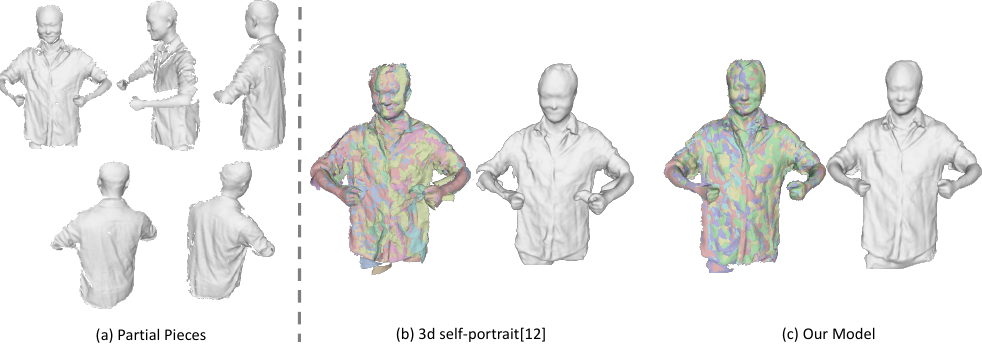
Figure 10. Comparison with 3D self-portrait. ( a ) some sampled partial pieces; ( b ) the results from 3D self-portrait [12]; ( c ) the results we get with our approach. We have colored the deformed pieces with different colors to better demonstrate the alignment results.